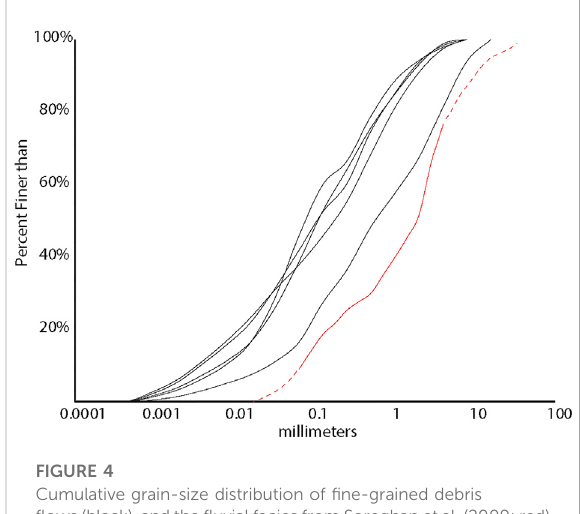
FIGURE 4 Cumulative grain-size distribution of fi ne-grained debris fl ows (black), and the fl uvial facies from Soreghan et al. (2009; red) with dashed lines inferred to extend the